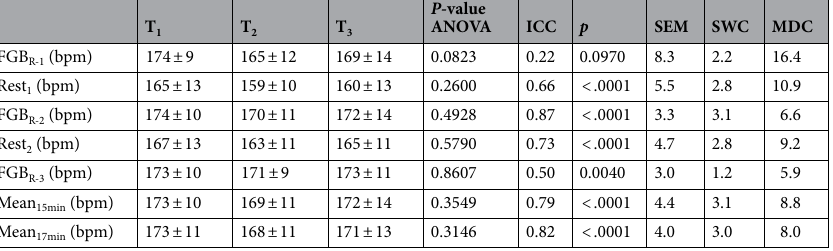
Table 3. Repeatability of heart rate during Fight Gone Bad. FGB R-1 , Fight Gone Bad Round 1; FGB R-2 , Fight Gone Bad Round 2; FGB R-3 , Fight Gone Bad Round 3; Mean 15min , mean of FGB R-1 , FGB R-2 and FGB R-3 ; ICC, interclass correlation coefficient; MDC, minimal detectable change; Mean 15min , mean of FGB TOTAL ; SEM, standard error of measurement; Rest 1 , rest period between round 1 and 2; Rest 2 , rest period between round 2 and 3; SWC, smallest worthwhile